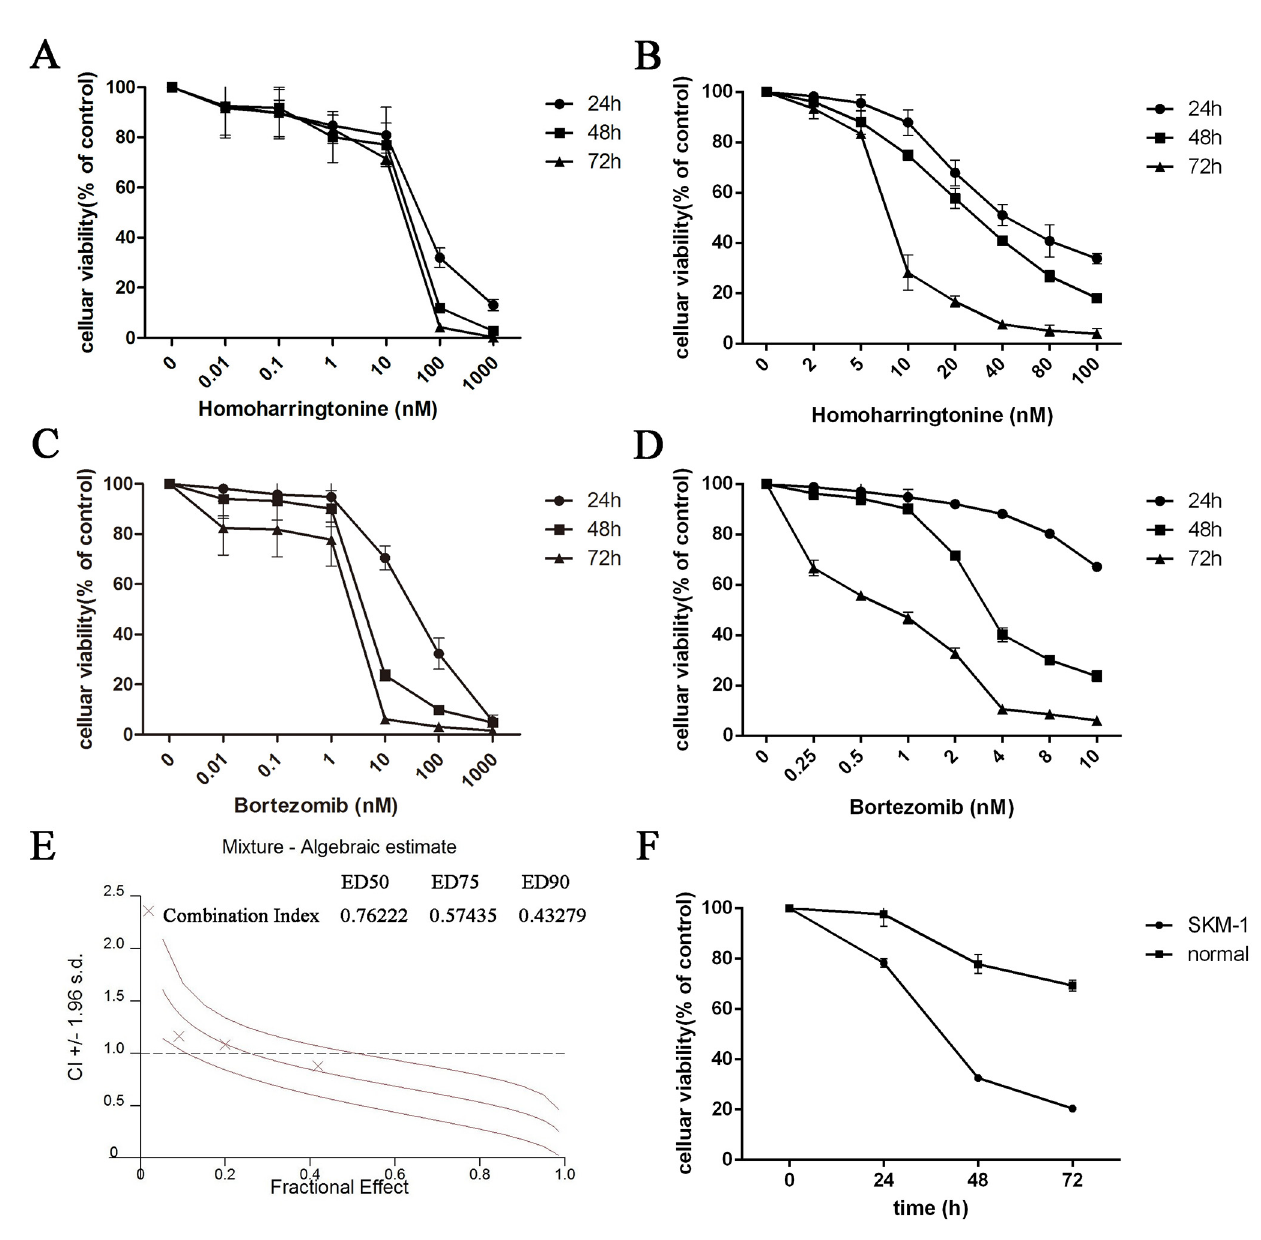
Fig 1. HHT and Bortezomib inhibited the cell viability of SKM-1 cells. (A) Time- and dose – response curves of HHT from 0.01 nM to 1000 nM. (B) Time- and dose – response curves of HHT from 2 nM to 100 nM. (C) Time- and dose – response curves of Bortezomib from 0.01 nM to 1000 nM. (D) Time- and dose – response curves of Bortezomib from 0.25 nM to 10 nM. (E) CI values for HHT and Bortezomib combination treatments at the molar ratio of 10.4:1. (F) Celluar viability of SKM-1 or normal PBMC cells simultaneously treated with 46.20 nM HHT and 4.46 nM